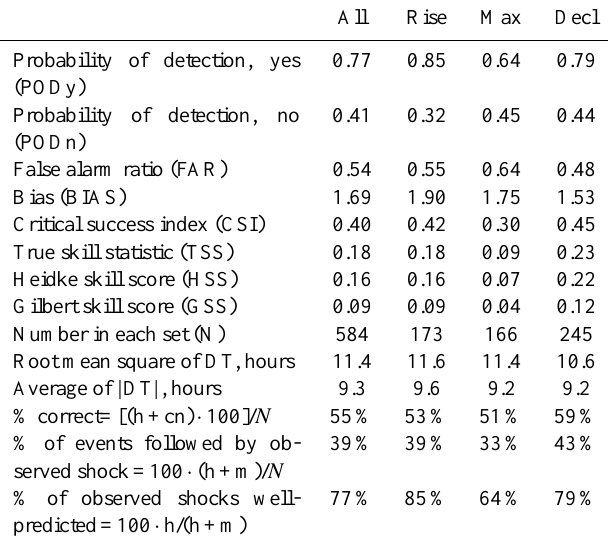
Table 2. Overview of the values of a range of statistical parameters derived using the HAFv.2 model for the key phases of solar cycle 23 and for the total